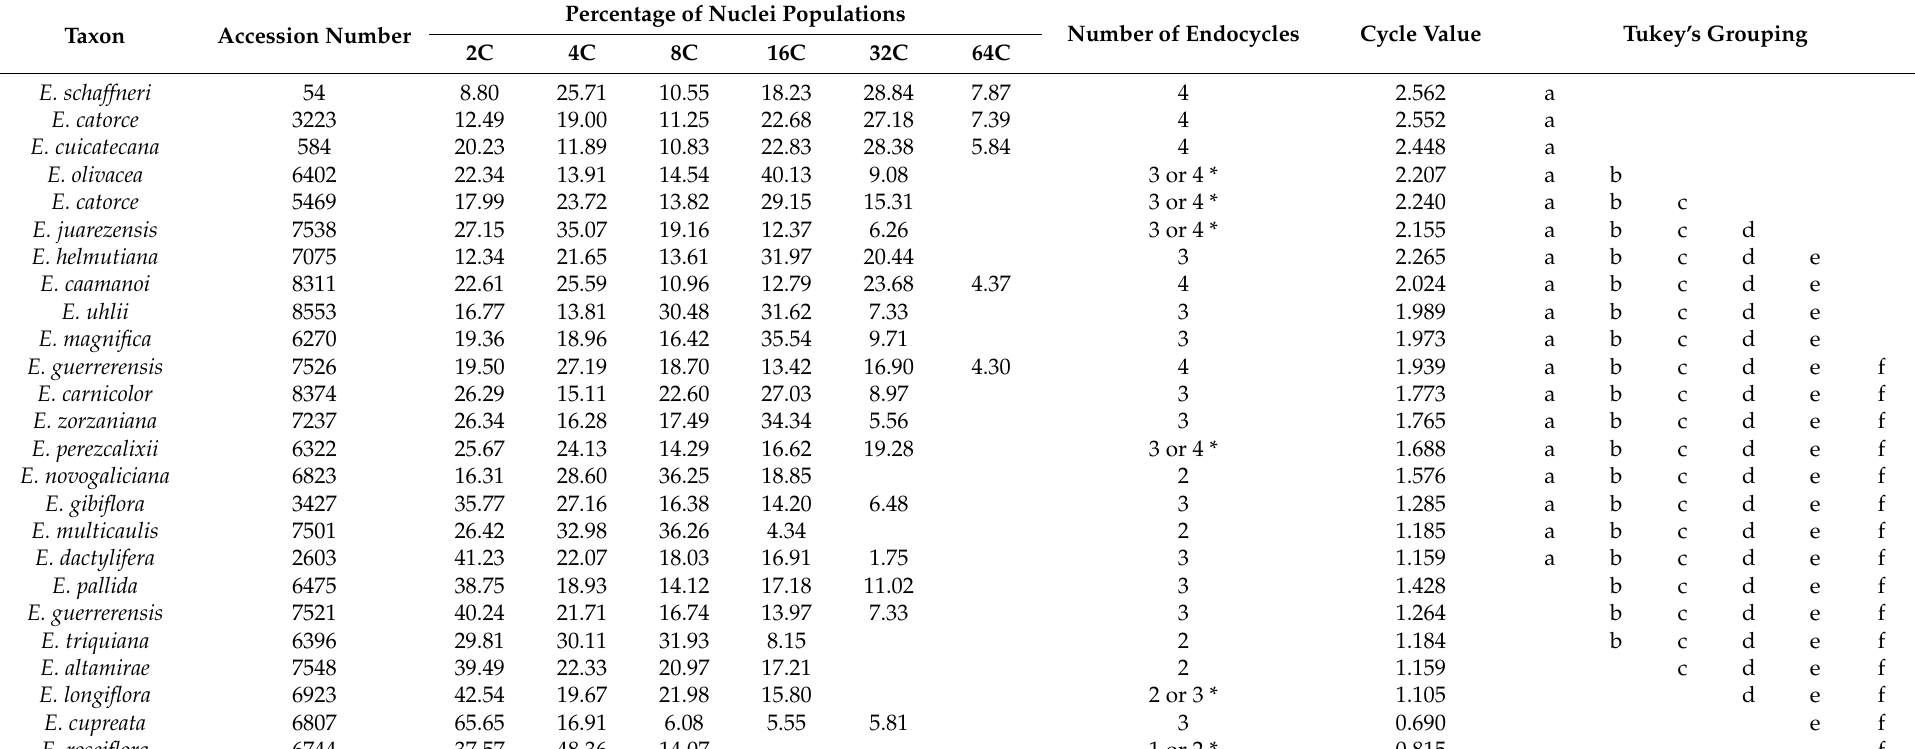
Table 4. Analysis of endopolyploidy nuclei, number of endocycles, Cycle value, and Cycle value Tukey–Kramer test in 23 Echeveria